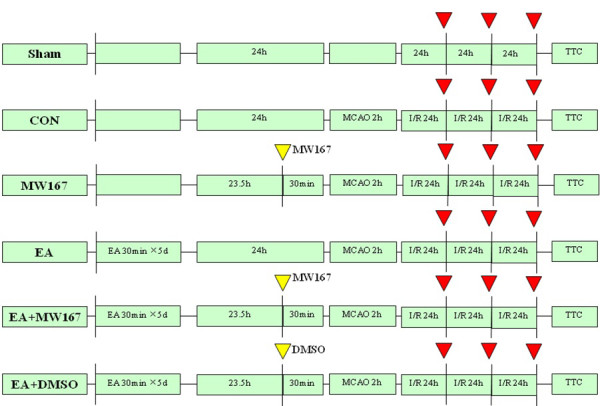
Experimental protocol diagram 3. Forty-eight male SD rats were randomly divided into 6 groups(n = 8 each): Sham, CON, EA, MW167, EA + MW167 and EA + DMSO group. At 30 min before MCAO(yellow arrow), intraventricular injections were performed. MW167 and DMSO were given respectively. At 24 h, 48 h and 72 h after ischemia/reperfusion (red arrow), neurological function scores were assessed in the 6 groups respectively. At 72 h after ischemia/reperfusion, all rats were anesthetized and killed, the infarct volumes were measured.